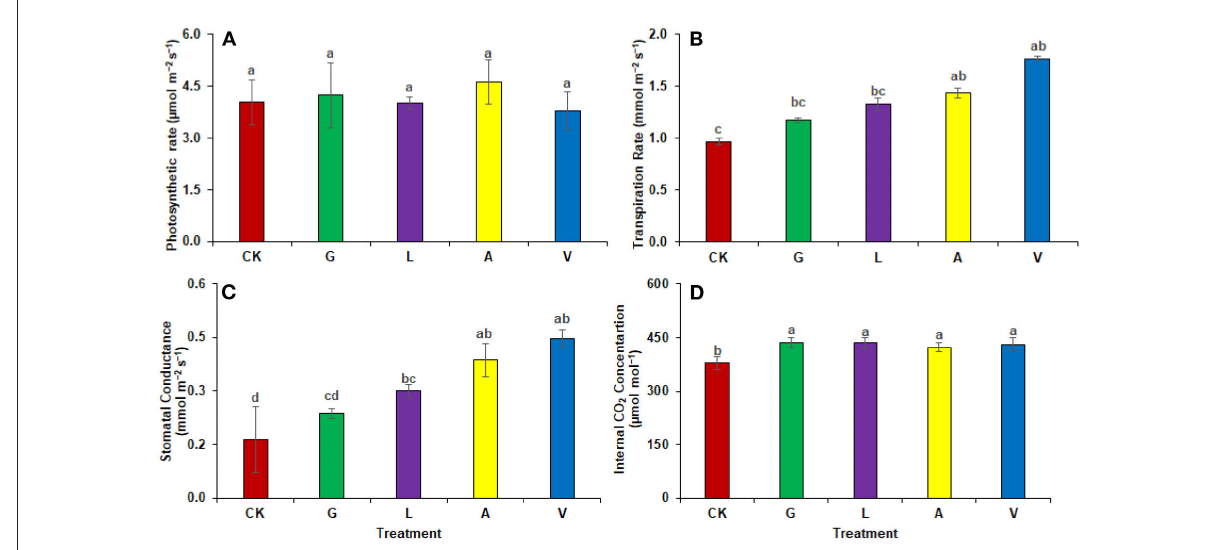
FIGURE8 Gaseous exchange parameters: (A) Photosynthetic rate, (B) Transpiration rate, (C) Stomatal conductance (D) Internal CO 2 concentration observed in experiment 1 using chemical fertilizer (CK), glycine (G), lysine (L), aspartic acid (A), and vitamin B complex (V). The values mentioned herein are indicated as mean ± S.D and the lowercase letters indicate the significant difference among the means.